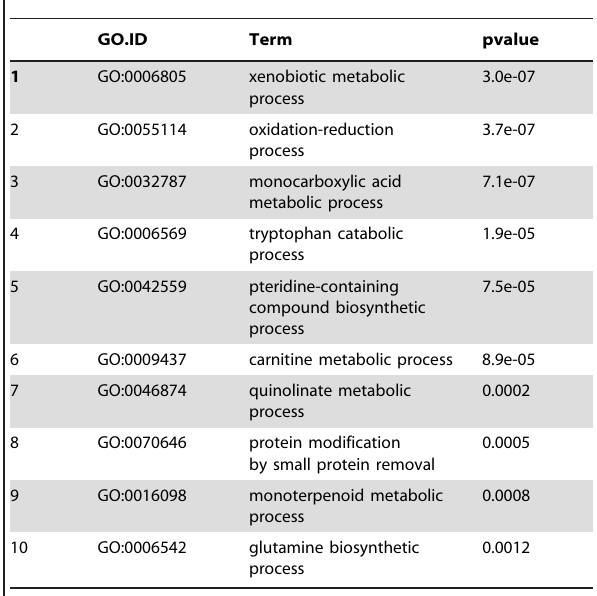
Table 6. Gene Ontology (GO) analysis.